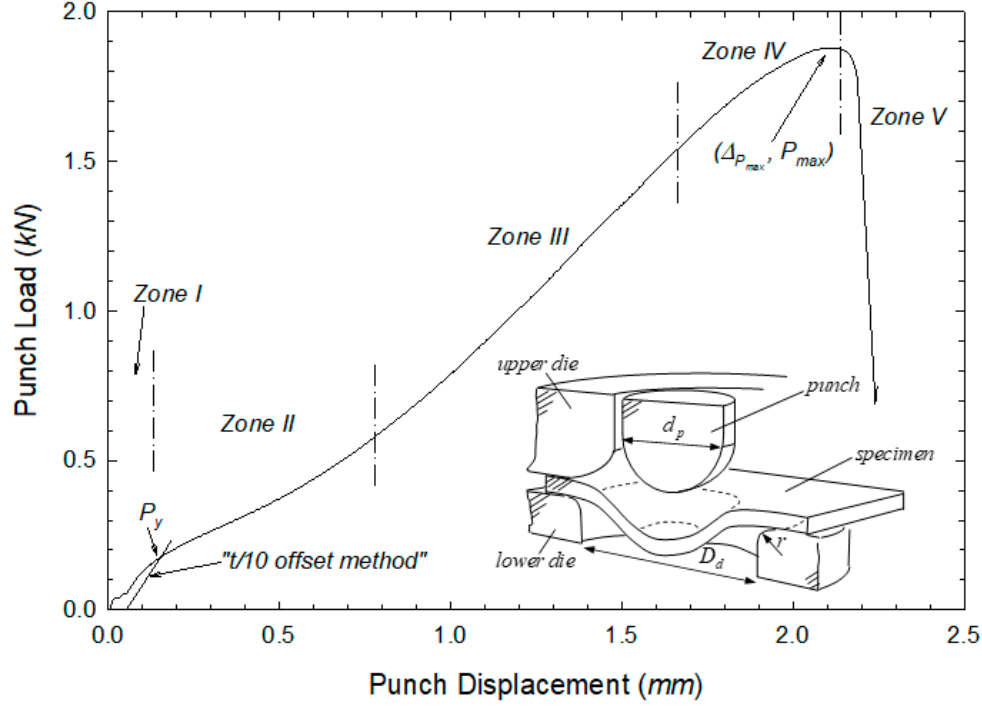
Figure 4. Typical load–displacement curve and schematic description of the experimental setup involved in the small punch test (SPT).